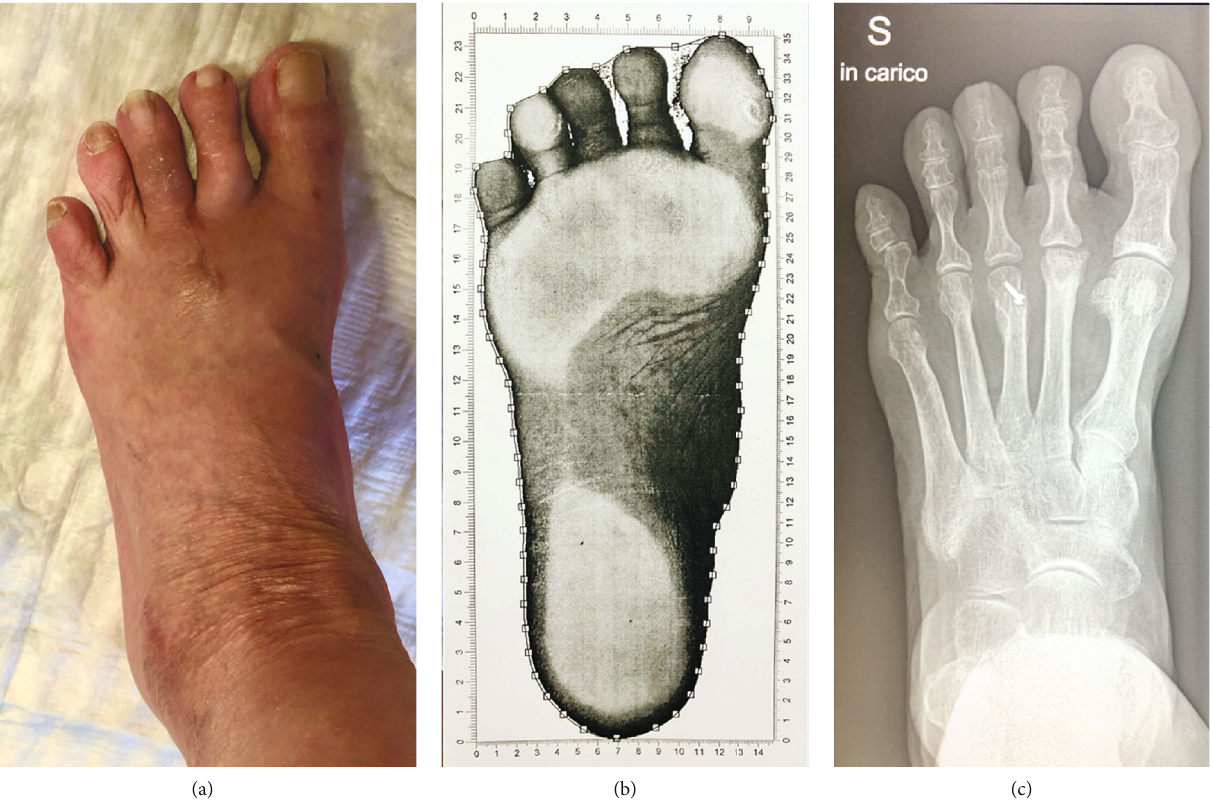
Figure 5: Results at the 3-month follow-up after removing the K-wire, with (a) photograph while weight bearing, (b) walking analysis, and (c) plane